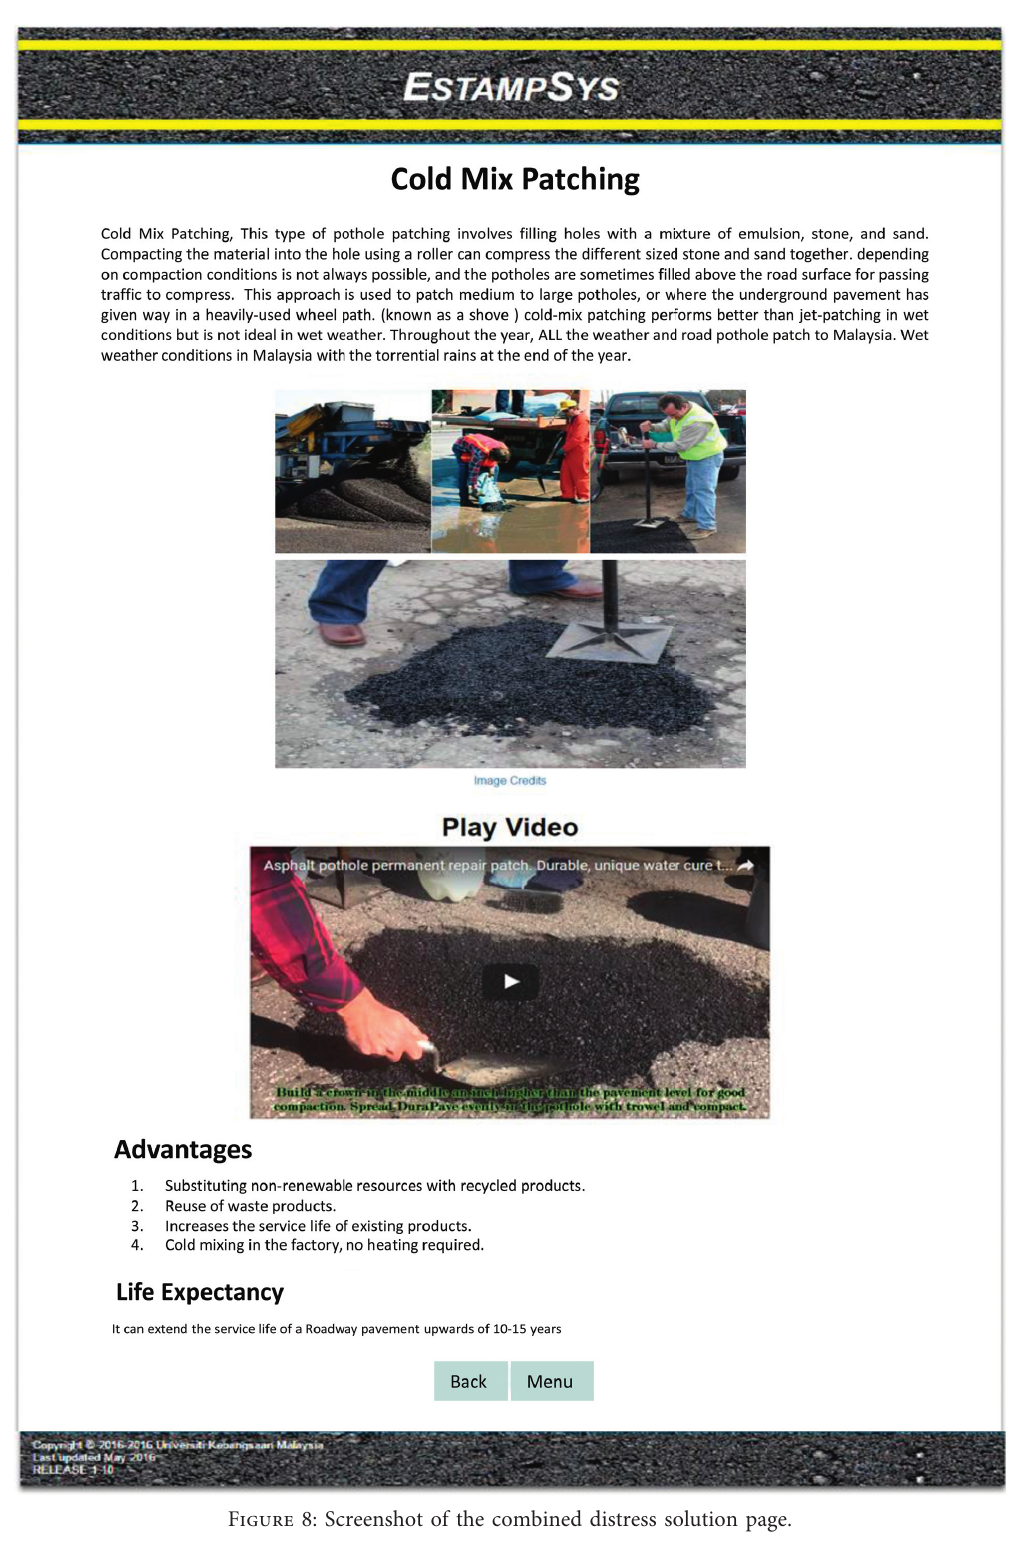
Figure 8: Screenshot of the combined distress solution